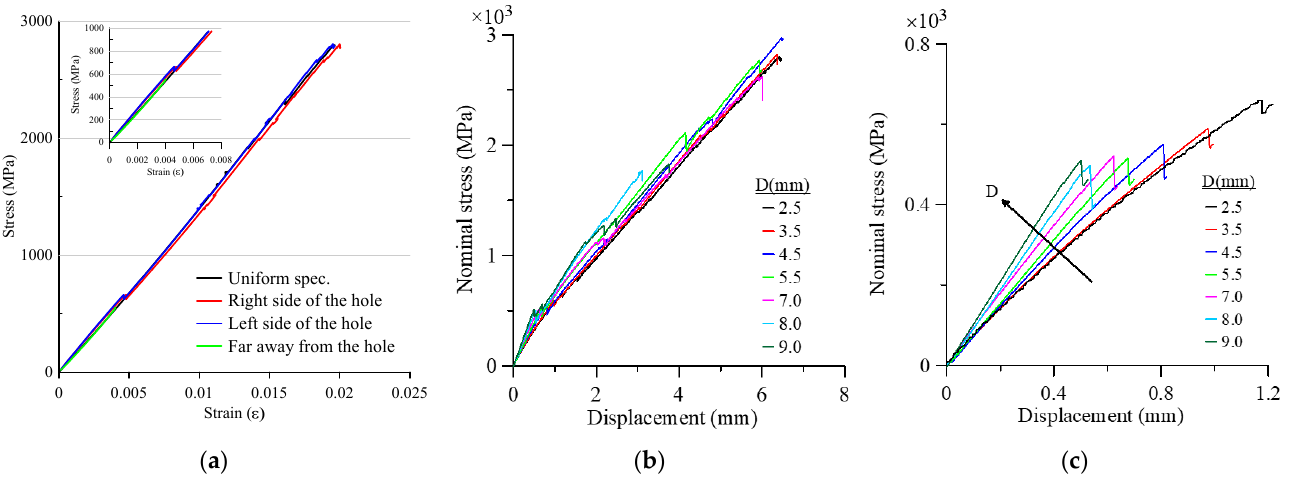
Figure 11. Mechanical response of holed coupons in terms of nominal stress; ( a ) stress–strain of 2.5 mm holed coupon; ( b ) stress –displacement full curves up to fracture; ( c ) expanded region where σ r is observed for the various holes’ diameter (the arrow indicates increasing in D). Table 4. Tensile stresses for holed coupons at different holes diameter.